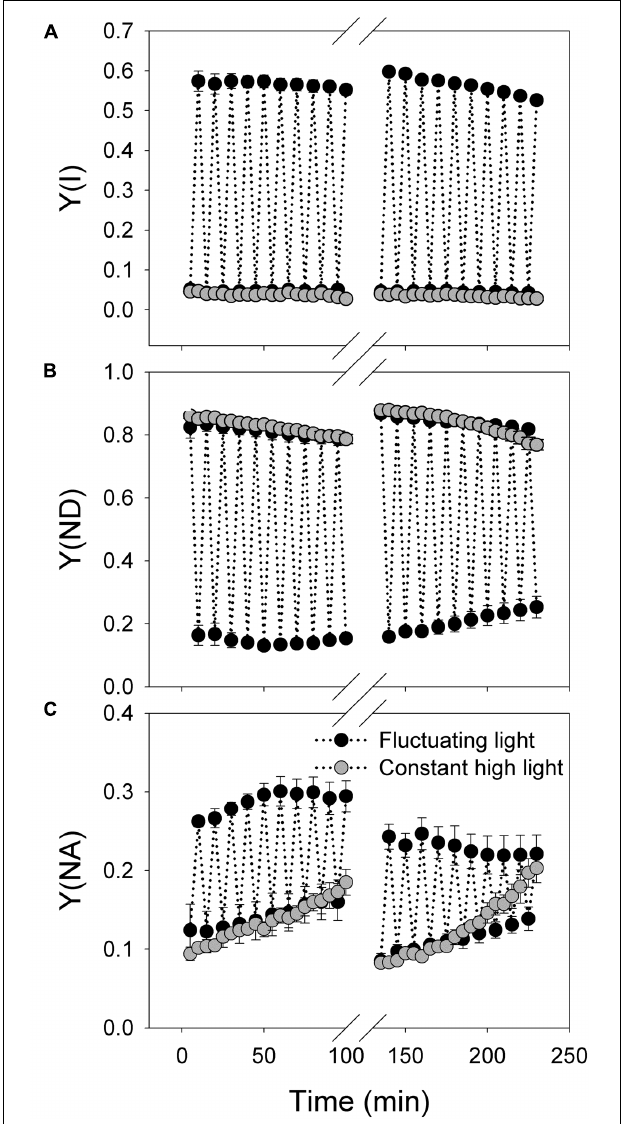
FIGURE 4 | Response of PSI photosynthetic parameters to intense fluctuating light in P. henryi . (A) Y(I); (B) Y(ND); (C) Y(NA). After dark adaptation for 30 min, leaves were exposed to fluctuating light alternating between 2258 and 94 µ mol photons m − 2 s − 1 every 5 min for 100 min. Then, leaves were incubated in darkness for 30 min, and the values of P m and F v / F m were measured. Afterward, leaves were treated with fluctuating light alternating between 2258 and 94 µ mol photons m − 2 s − 1 every 5 min for 100 min. Photosynthetic parameters were measured every 5 min. Y (I), quantum yield of PSI; Y (ND), the fraction of P700 that is already oxidized by actinic light; Y (NA), the fraction of P700 that cannot be oxidized due to acceptor side limitation. The means ± SE were calculated from four plants.